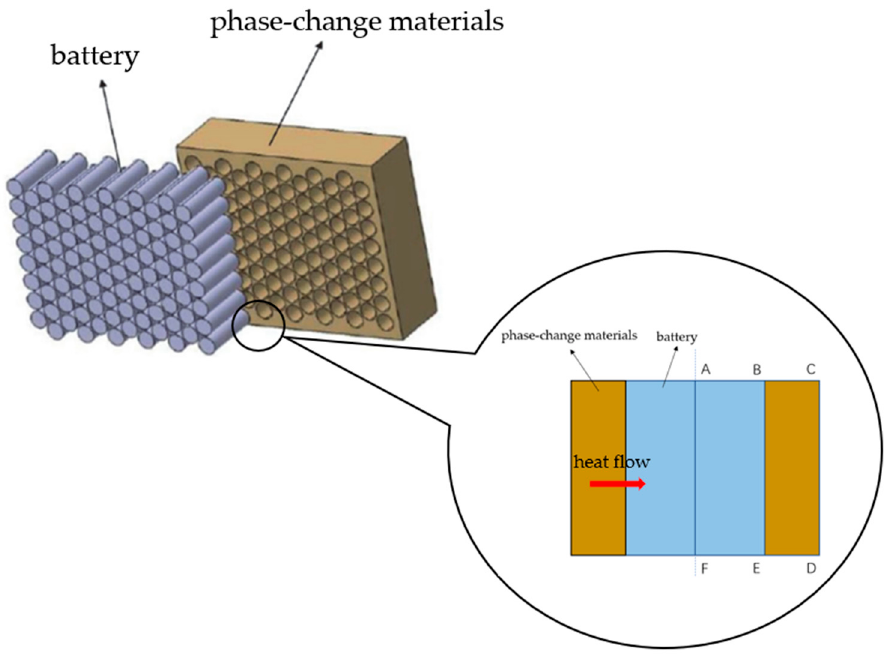
Figure 9. Schematic diagram of the thermal management structure of the battery using phase-change materials.